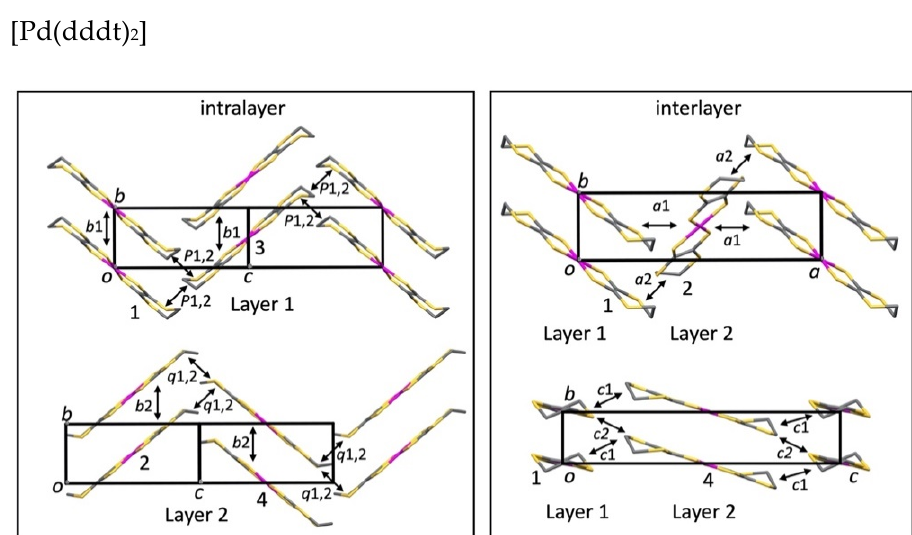
Figure 1. Molecular structure and crystal structure of [Pd(dddt) 2 ] at 5.9 GPa with symbols of intermolecular couplings. Palladium, sulfur and carbon atoms are shown in pink, yellow and grey, respectively. Hydrogen atoms are omitted for clarity.